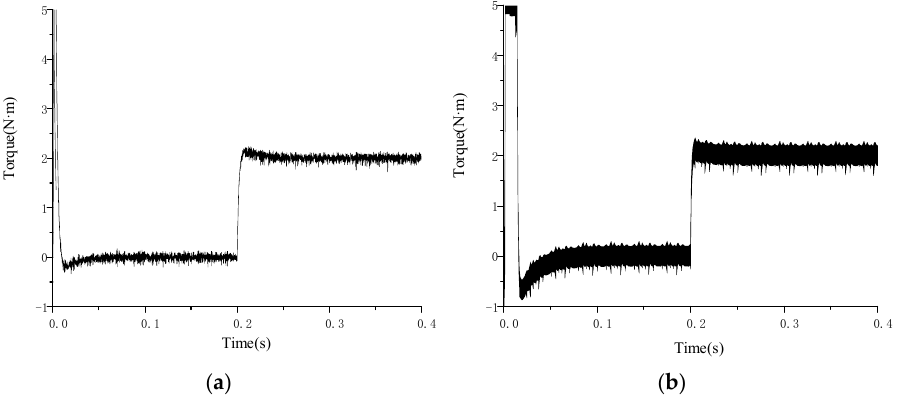
Figure 14. Servo motor torque curve: ( a ) sliding-mode control DTC torque curve; ( b ) traditional DTC motor torque curve.